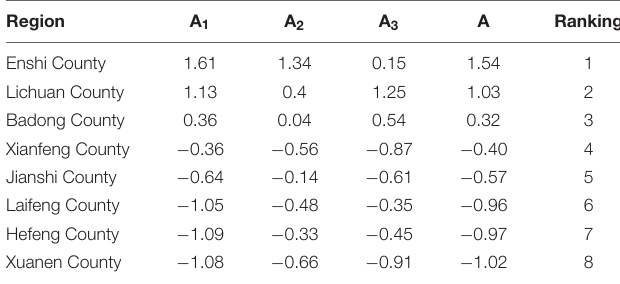
TABLE 15 | Scores and rankings of EAP’s infrastructure competitiveness (A 3 ).